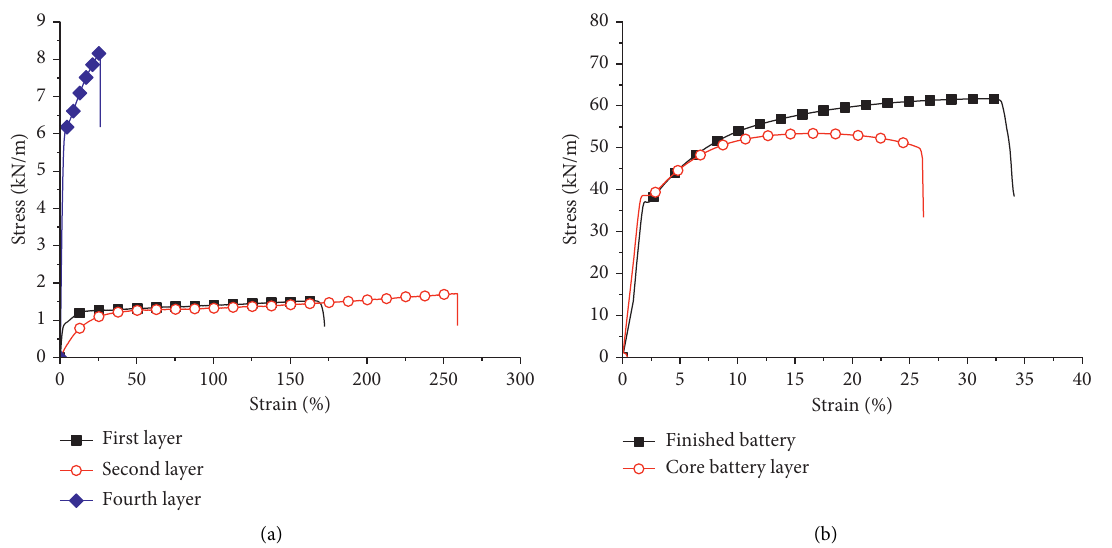
Figure 6: Tensile stress-strain curves of each layer of material. (a) The first, second, and fourth layers. (b) The third layer and finished product.